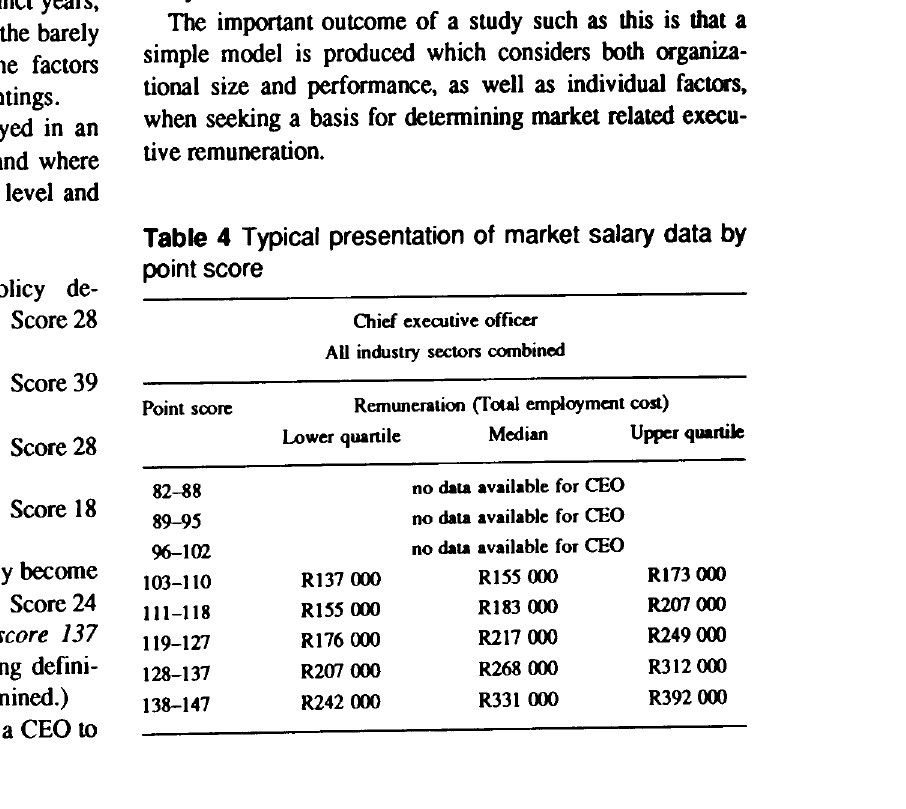
Table 3 Point values for Group 2 factors